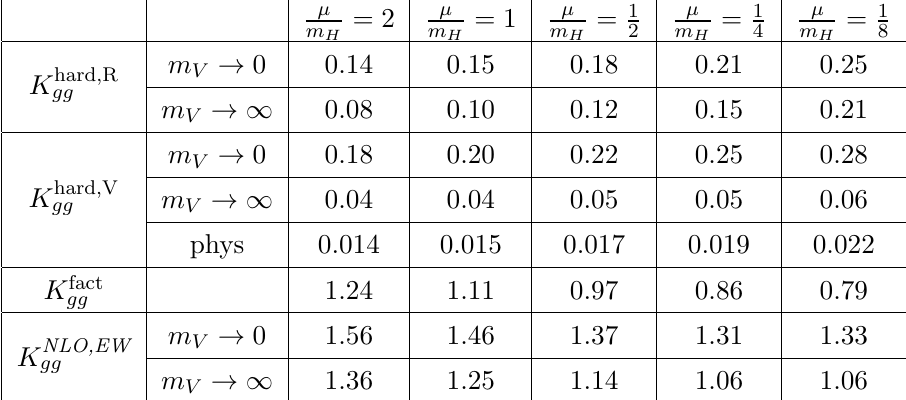
Table 1. K -factors of the various components of the NLO QCD-EW corrections within di(cid:11)erent approximations.